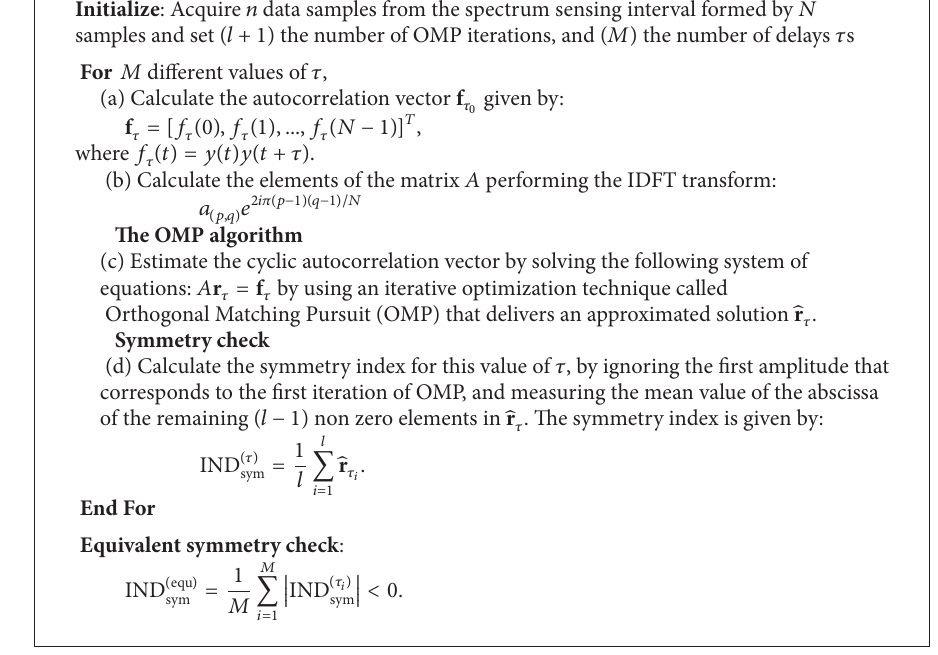
Algorithm 2: Steps of the CAF symmetry-based detector.